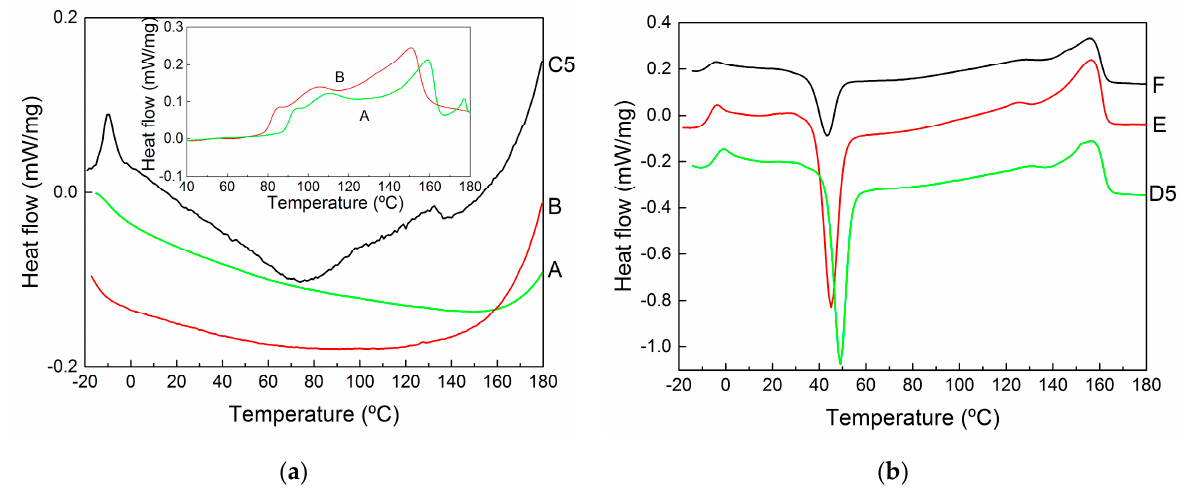
Figure 6. DSC curves (measured during the second heating and vertically shifted for better visualization of the results) of samples recovered from the biomass digestion in NaOH ( a ) or extracted with CHCl 3 ( b ). The inset in ( a ) shows the DSC curves acquired during the first heating of the pellets.